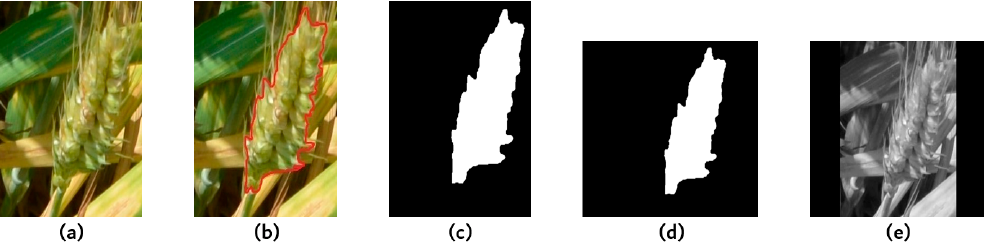
Figure 2. The segmentation dataset of single wheat ear. ( a ) Original image, ( b ) outline label image, ( c ) label binary image, ( d ) label binary image resampled to 256 × 256 and edge fill 0, ( e ) the image is grayscaled after original image is padded with 0 and resampled to 256 × 256.